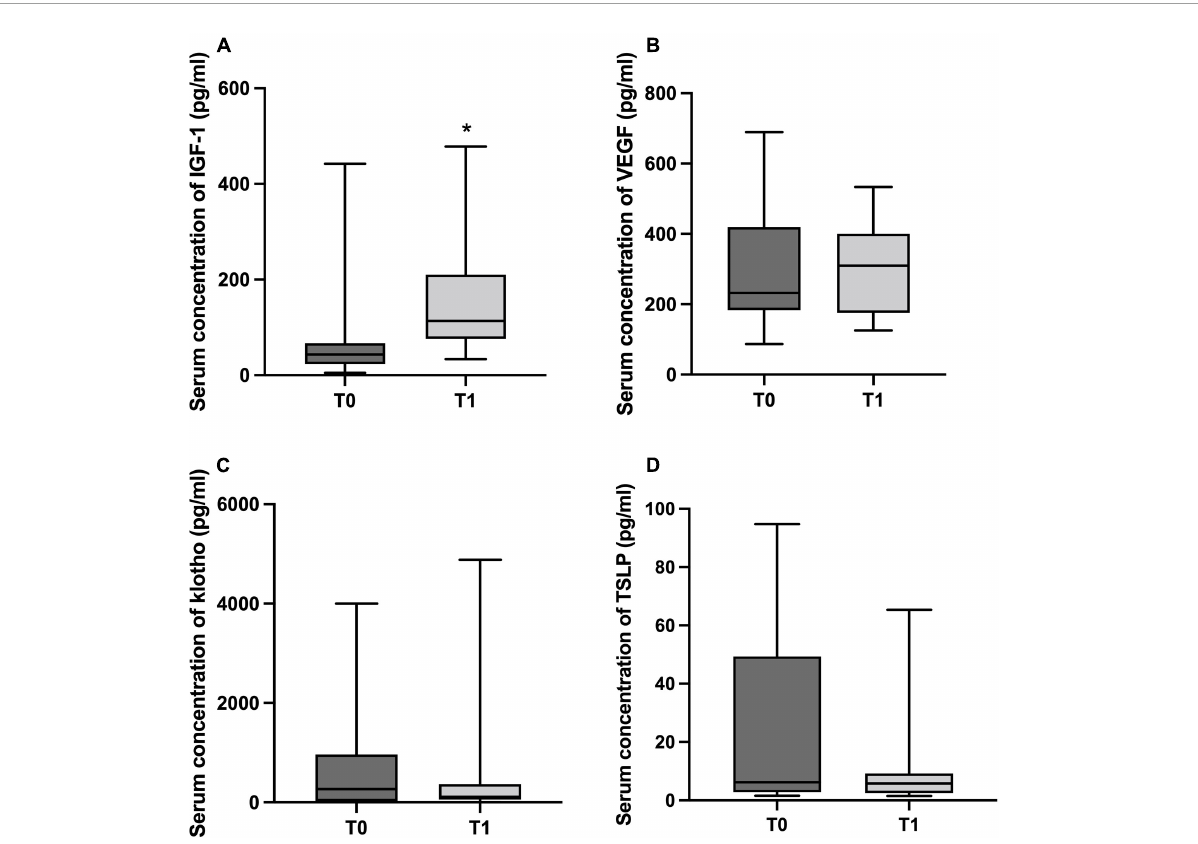
FIGURE4 The boxplots show the median/minimum-maximum values for serum concentration (pg/ml) of aging-associated markers before (T0) and after 6 months of physical distancing (T1). (A) insulin-like growth factor-1 (IGF-1, T0: 36.63/4.88-441.90 and T1: 113.30/33.66-478.20), (B) vascular endothelial growth factor (VEGF, T0: 230.40/87.30-548.90 and T1: 309.40/125.30-533.90), (C) klotho (T0: 267.50/0-4002.00 and T1: 115.5/0-4882.00), and (D) thymic stromal lymphopoietin (TSLP, T0: 5.51/1.62-94.73 and T1: 5.61/1.57-65.35). * differences between groups (Wilcoxon test, p <